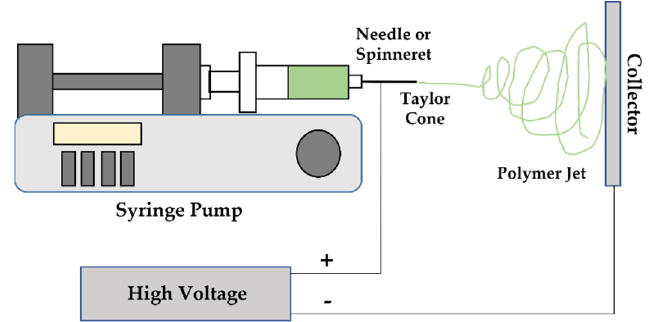
Figure 1. Schematic representation of an electrospinning apparatus.